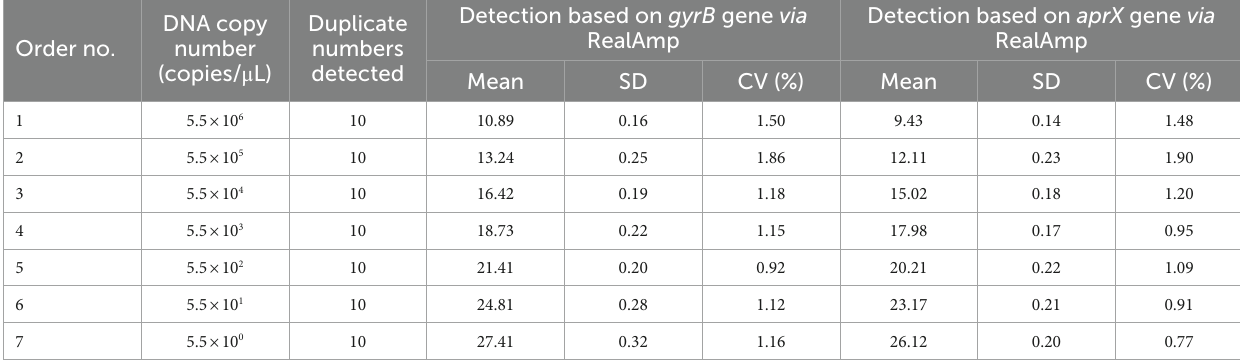
TABLE 2 Reproducibility results of the limit of detection of Pseudomonas lurida in skimmed milk solutions using RealAmp based on the gyrB and aprX genes.